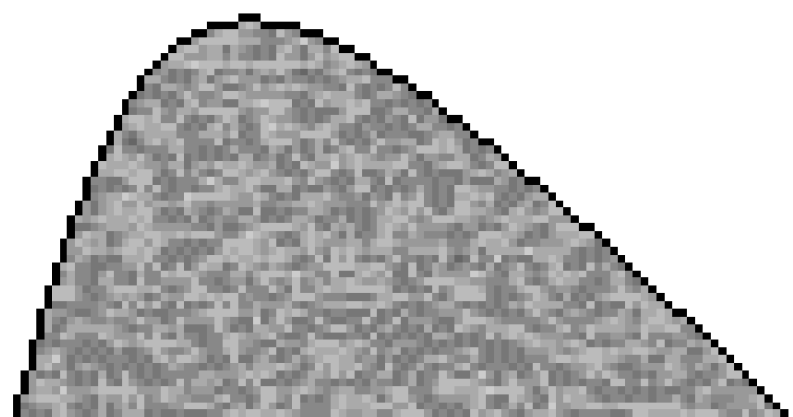
Figure 6. Subdomain distribution function f(x,y) for “lung disease zone” (LDZ). The grey scale indicates the spatial variation in the infiltrated properties of the lung tissue.